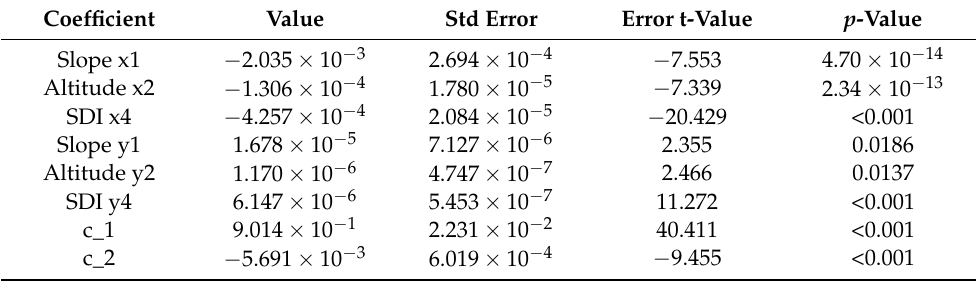
Table 3. Coefficient of the LM without aspect. RMSE = 0.2109 cm/year with 8623 degrees of